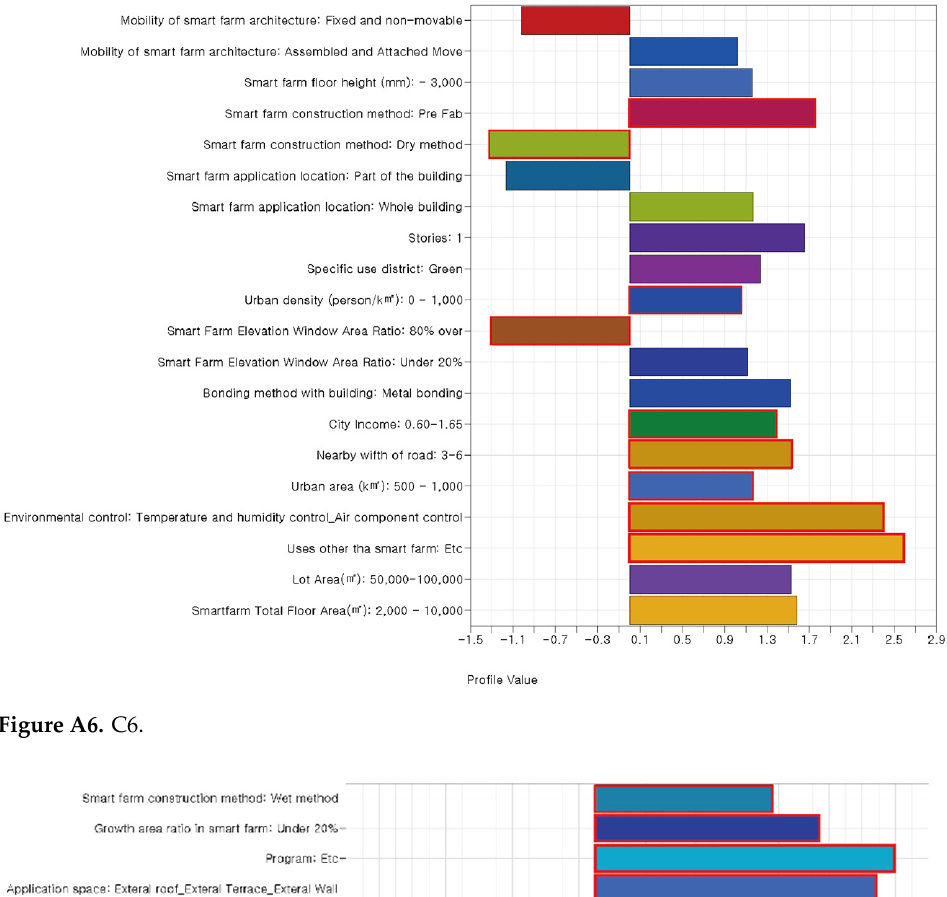
Figure A6. C6. Figure A6. C6.